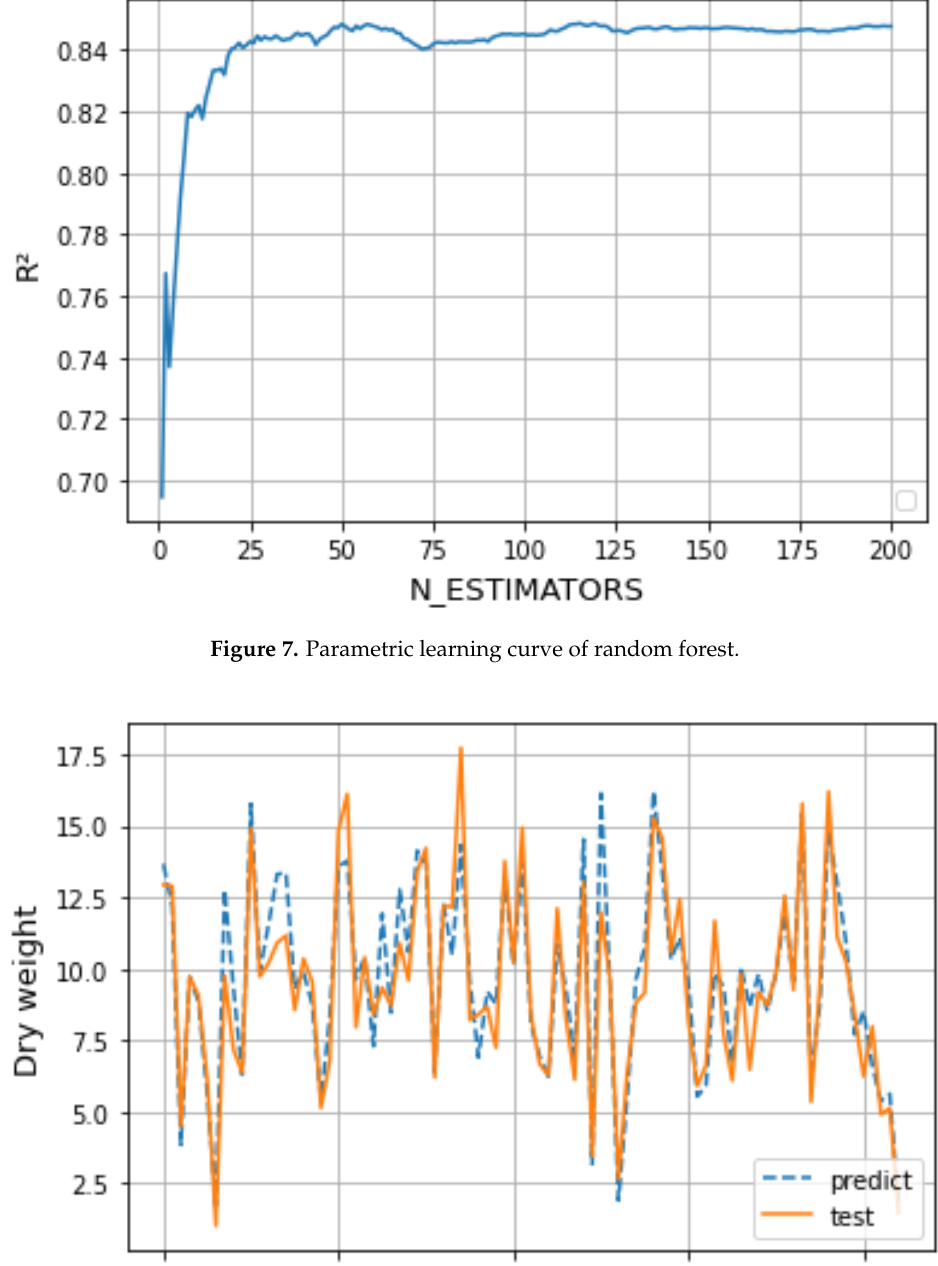
Table 5. 𝑅 2 and 𝑀𝐴𝑃𝐸 for the dry weight model.